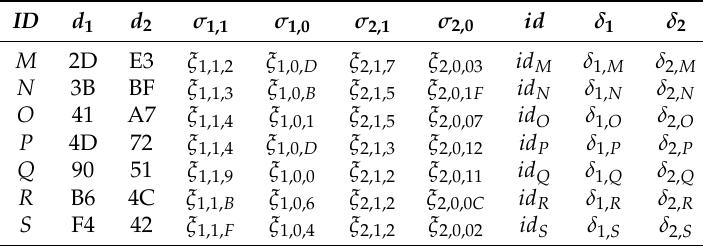
Table 8. Encrypted disguised object order generation by DataNode 1 .